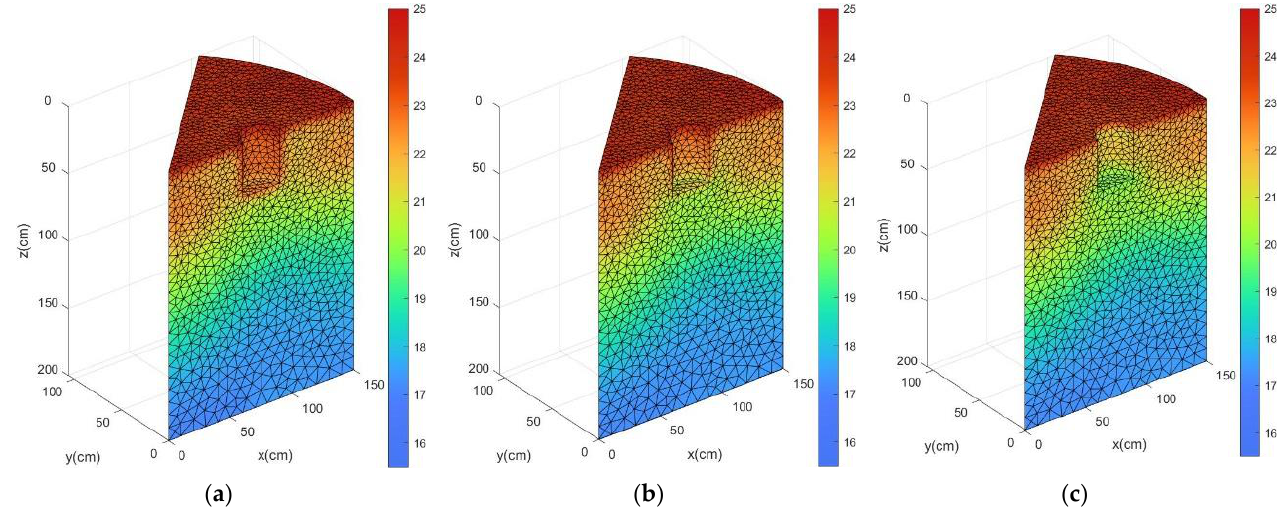
Figure 14. Simulation of soil temperature under different irrigation amounts. ( a ) Irrigation amount: 200 L; ( b ) Irrigation amount: 300 L; ( c ) Irrigation amount: 400 L. Table 11. Calculation of statistical indexes for soil temperature under different irrigation amount.